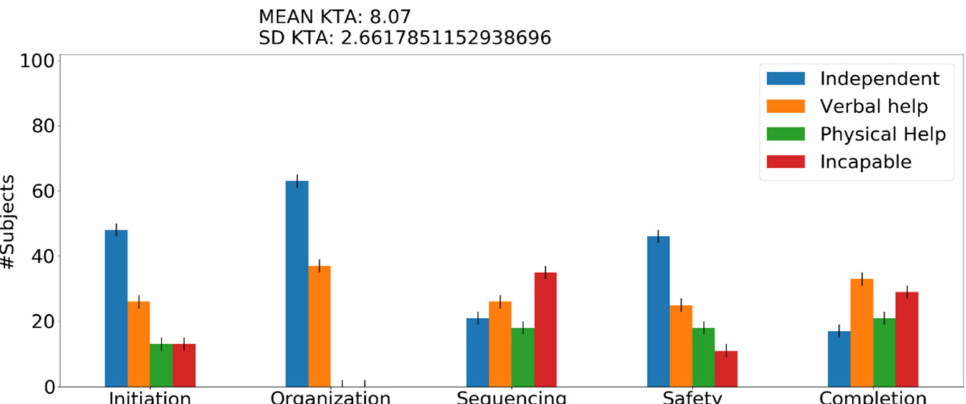
Figure 5. Main graphical output of the conceptual framework. The blue bars represent the number of subjects who completed a category of steps independently. The orange and green bars represent the number of subjects who requested help (verbal or physical) in a category of steps. The red bars indicate the number of subjects who are incapable of performing theses steps under a specific category. This activity corresponds to the washing hands activity with moderate